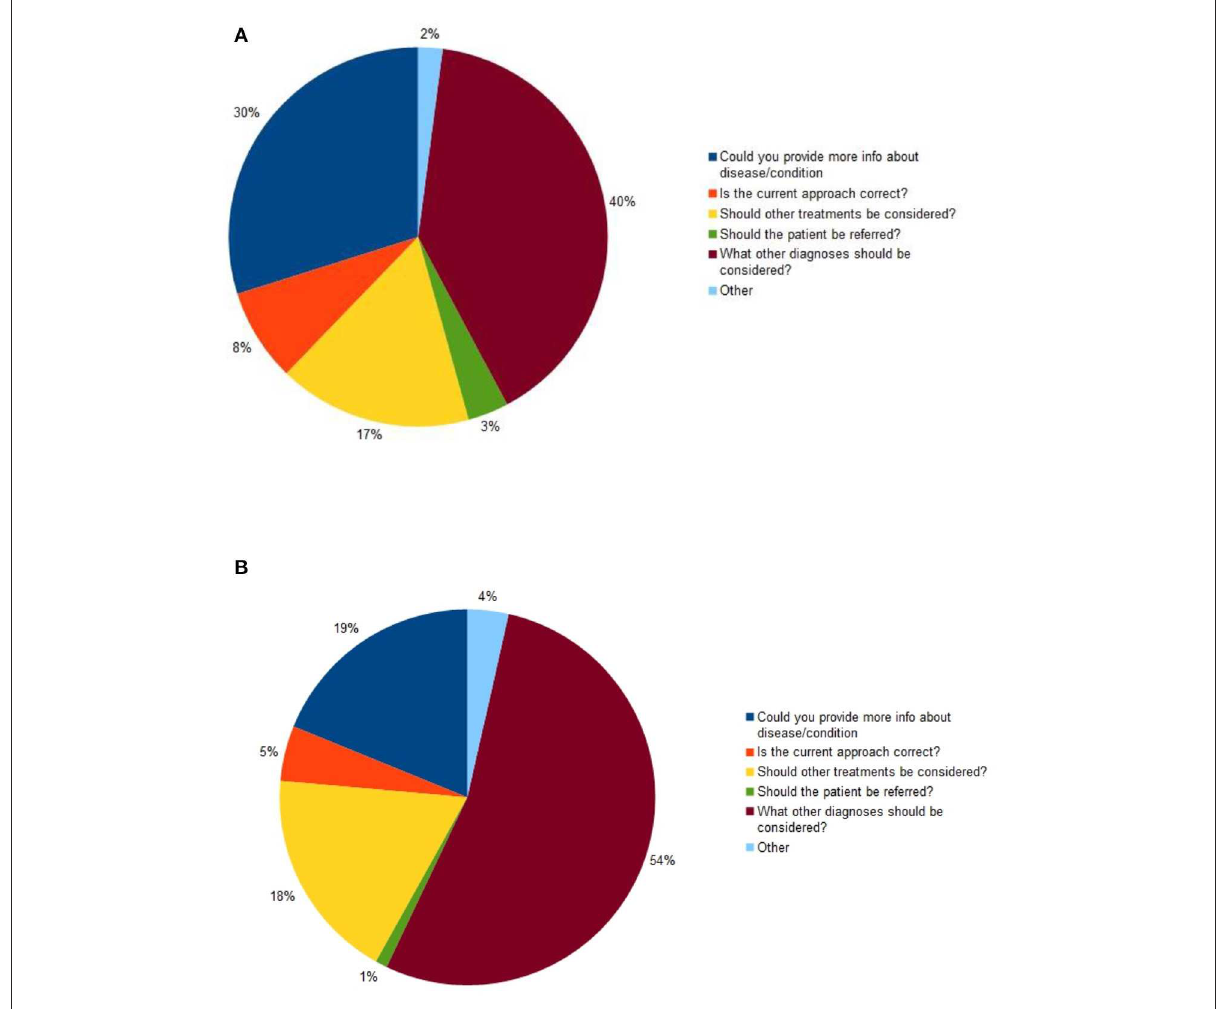
FIGURE3 Primary reason for referral: (A) during the baseline period ( n = 720); (B) during the pandemic period ( n =